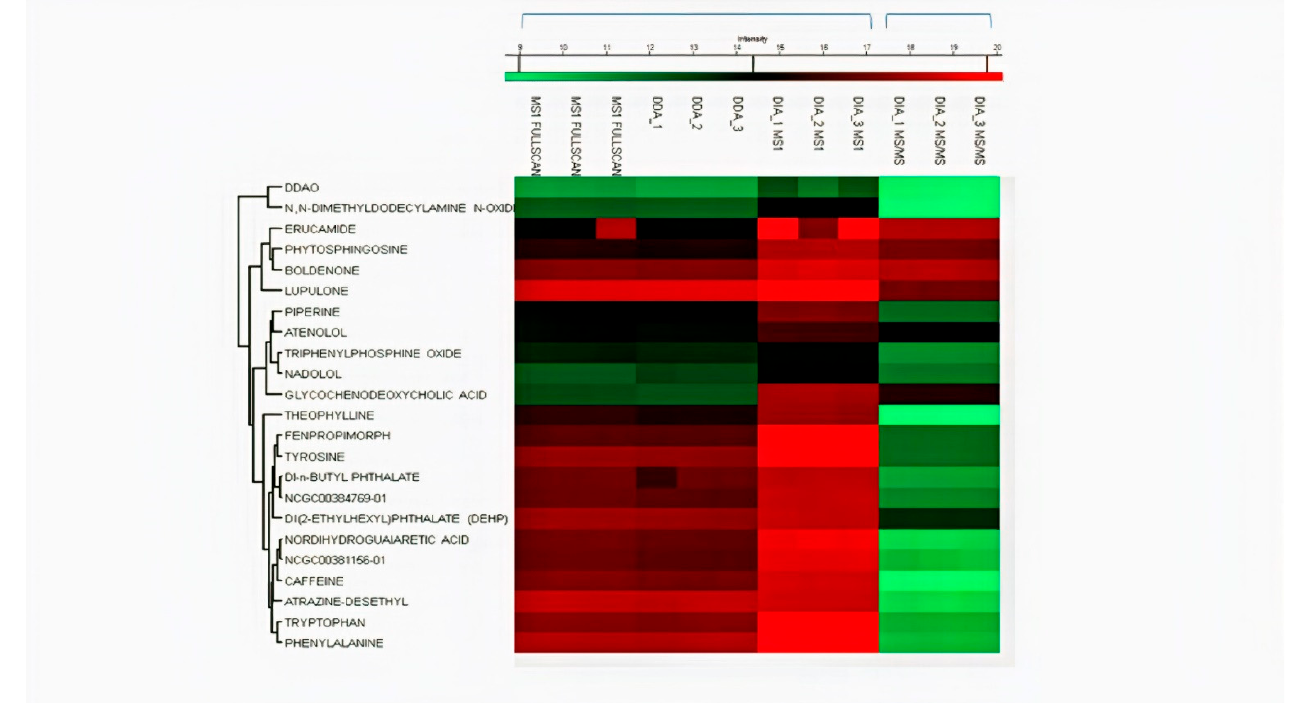
Figure 6. Clustering heatmap of serum metabolites analyzed by MS1 with three replicates in MS1 full-scan, DDA, and DIA modes and DIA MS2 level.